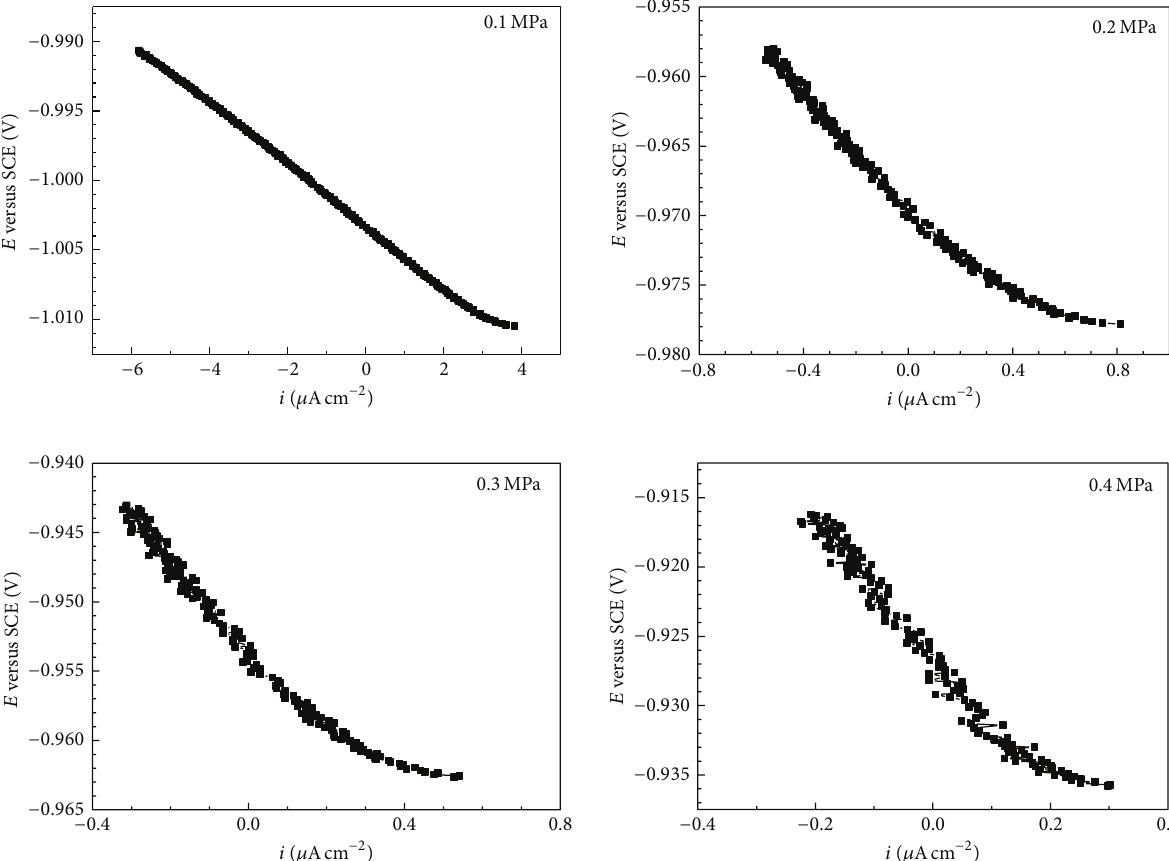
Figure 8: Linear polarization curves of galvanized steel under different hydrostatic pressure in CRS solution at 293 K after 2 days.